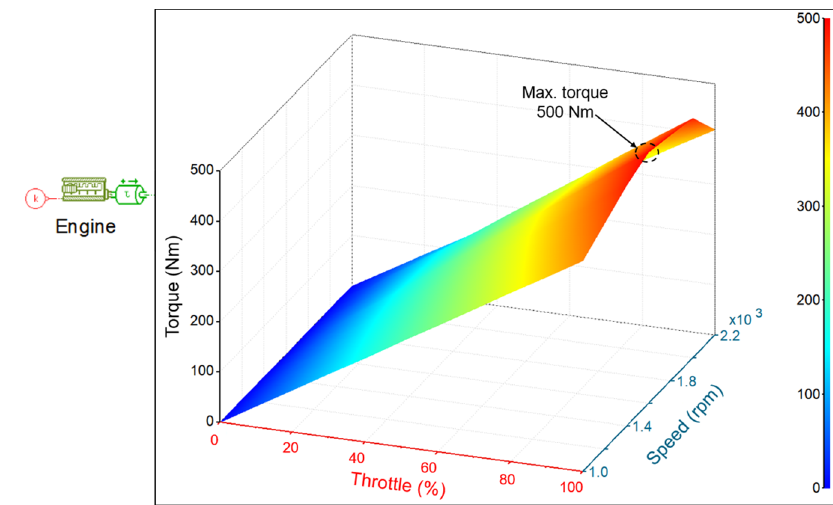
Figure 4. The 95-kW engine characteristics map used in this study.